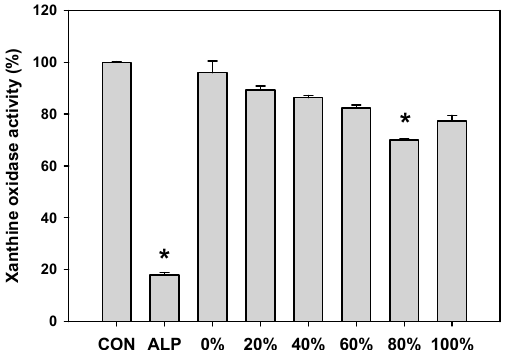
Figure 5. Xanthine oxidase inhibitory activities in ethanolic (0–100%) extracts of D. morbifera leaves (2 mg/mL) and allopurinol (ALP, 50 μ g/mL). Ethanolic extracts were prepared with 20–100% ethanol. The asterisk represents a value significantly different from the other groups ( p < 0.05). Values were the mean ± standard deviation ( n = 3).